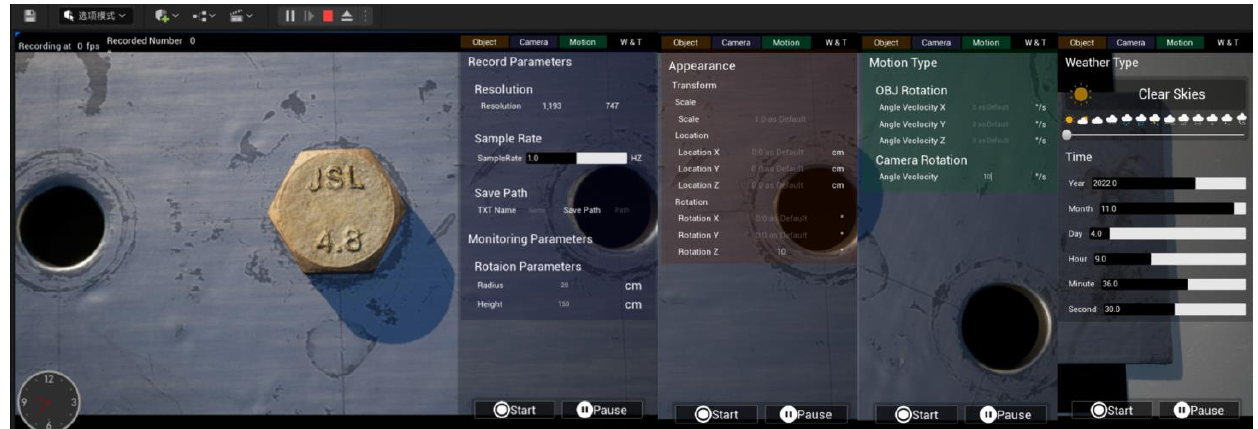
Figure 6. The bolt digital model. ( a ) White model; ( b ) Shading model.